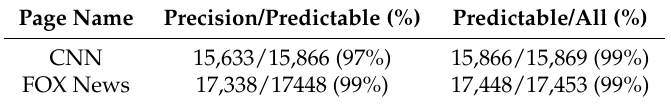
Table 3. Bandwagon effect cross validation—target to non-target, observed time = 120 min.